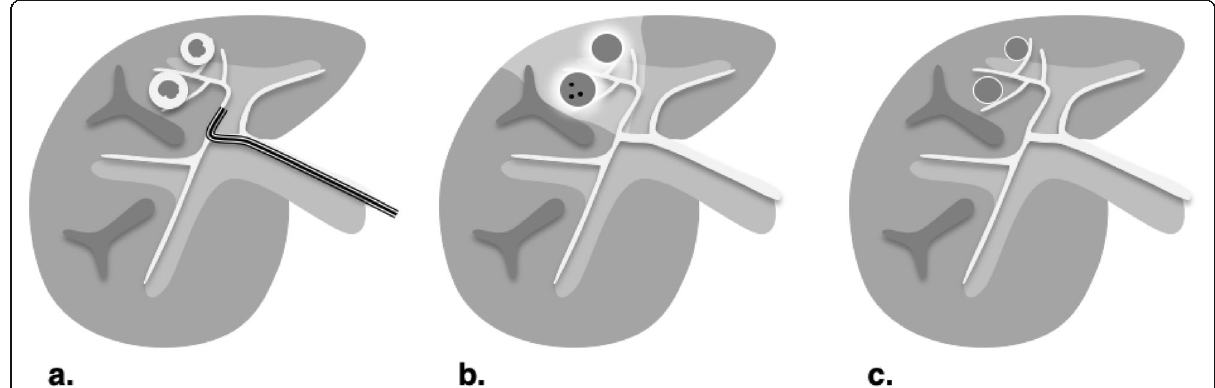
Fig. 20 Expected treatment response after transarterial bland embolization (TAE) and drug-eluting beads transarterial chemoembolization (DEB- TACE). Axial contrast-enhanced CT images of the liver obtained in late arterial phase are illustrated: a Pretreatment: typically used for bridging, debulking, or palliative treatment in patients with intermediate-stage hepatocellular carcinoma without vascular invasion. May be used alone or in combination with other treatments. b 1 – 3 months posttreatment: TAE and DEB-TACE show similar posttreatment evolution since drug-eluting beads are not visible on imaging. Contrary to TACE, since no hyperdense ethiodized oil is used, tumor viability is easier to assess on CT. The same following features as TACE may be seen: thin uniform rim enhancement around the treated zone, regional parenchymal enhancement, and intratumoral gas foci (up to 4 – 6weeks posttreatment). c ≥ 6months posttreatment: size of necrotic zone decreases over time. Regional parenchymal enhancement resolves. Rim enhancement along the treated zone may persist for months to years. At any point posttreatment, presence of nodular arterial phase hyperenhancement, washout appearance, or enhancement similar to pretreatment indicates recurrence or residual viable